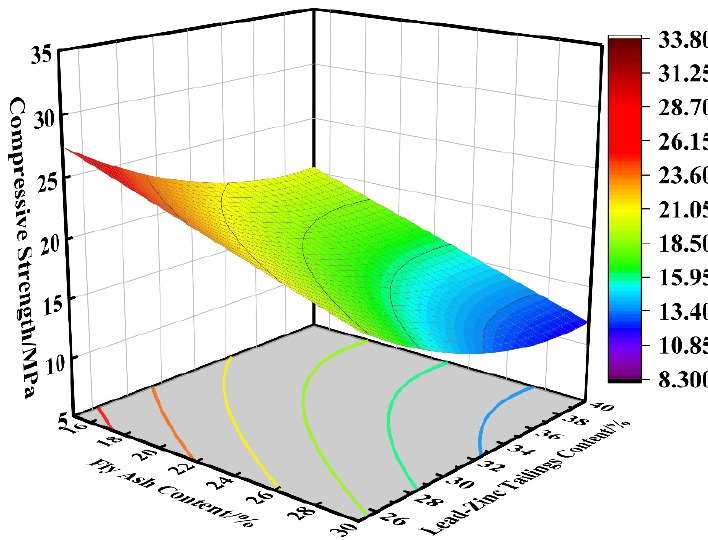
Figure 8. Effect of AB on compressive strength.